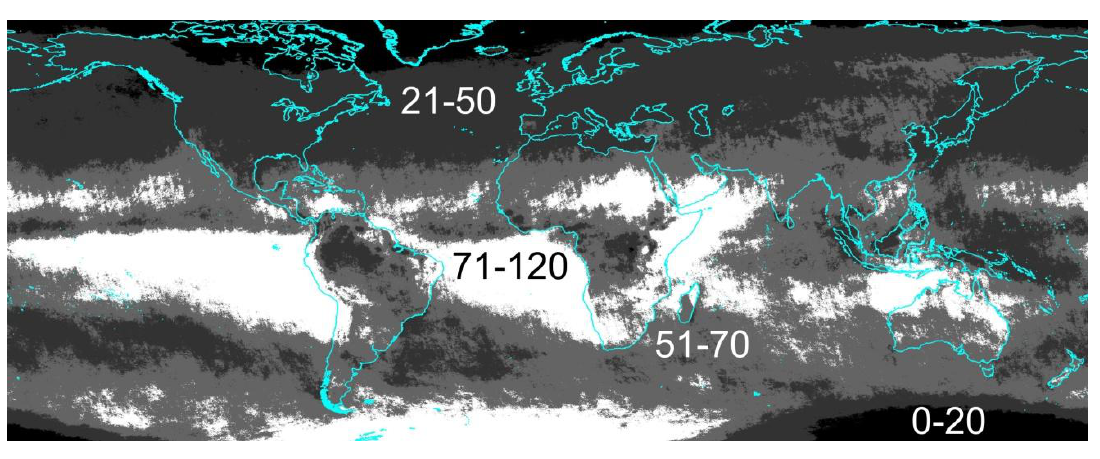
Figure 2. Tally of cloud-free coverages from DMSP satellite F16 for the year 2004.